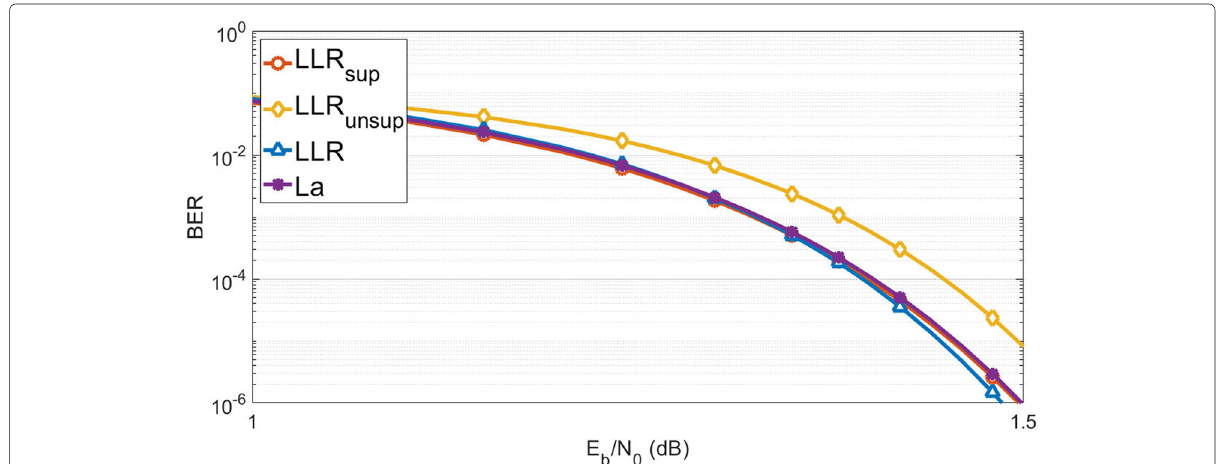
Fig. 10 BER comparison in Gaussian noise. BER comparison as a function of E b / N 0 between the supervised and unsupervised LLR approximations and the optimal LLR in additive Gaussian noise